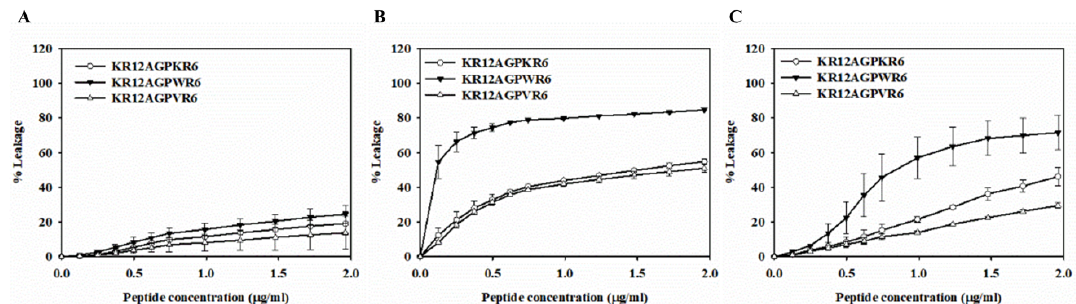
Figure 7. Peptide-induced permeabilization of LUVs by the designed peptides. Plot showed the percentage of calcein leakage of, KR12AGPKR6, KR12AGPWR6 and KR12AGPVR6 in 10 μ M ( A ) POPC/cholesterol, ( B ) POPC/LPS and ( C ) POPC/POPG LUVs. Results are presented as means ± standard deviations (SD); n = 3.